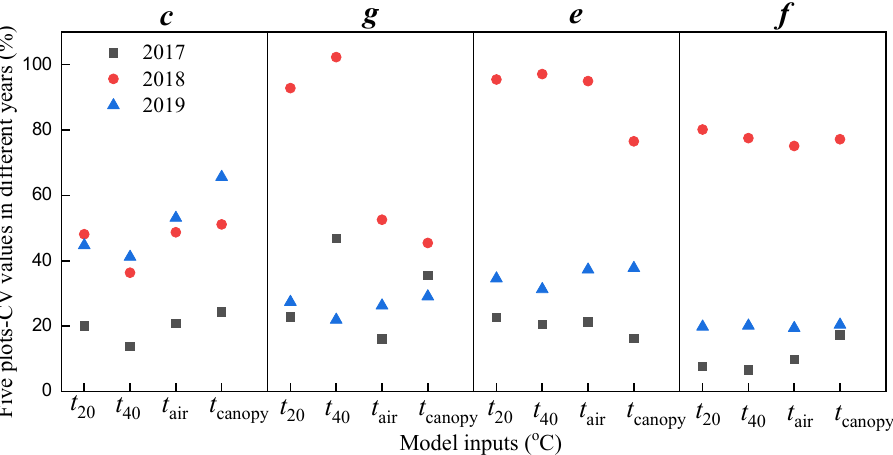
Figure 13. CV values for each R-logistic model parameter ( c , g , e , f ) with four inputs ( t 20 , t 40 , t air , t canopy ) among five plots in 2017–2019.